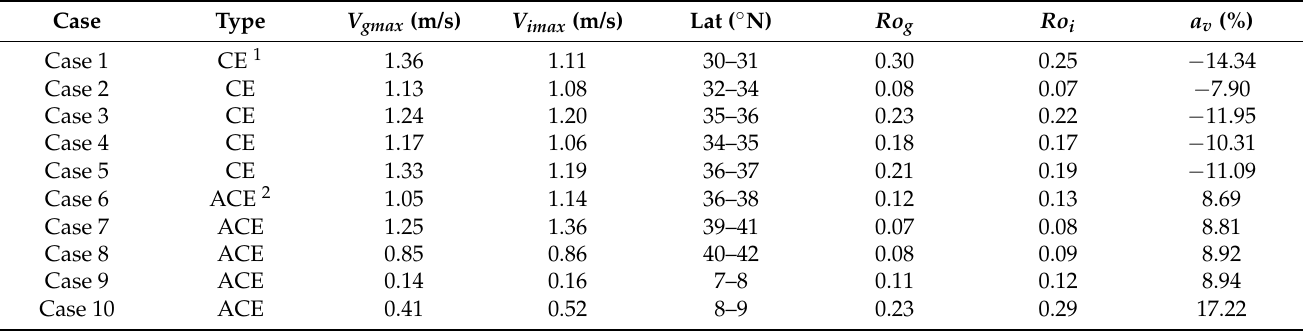
Table 1. Comparison of the cyclogeostrophic and geostrophic currents of ten eddies in the Northern Hemisphere on 12 August